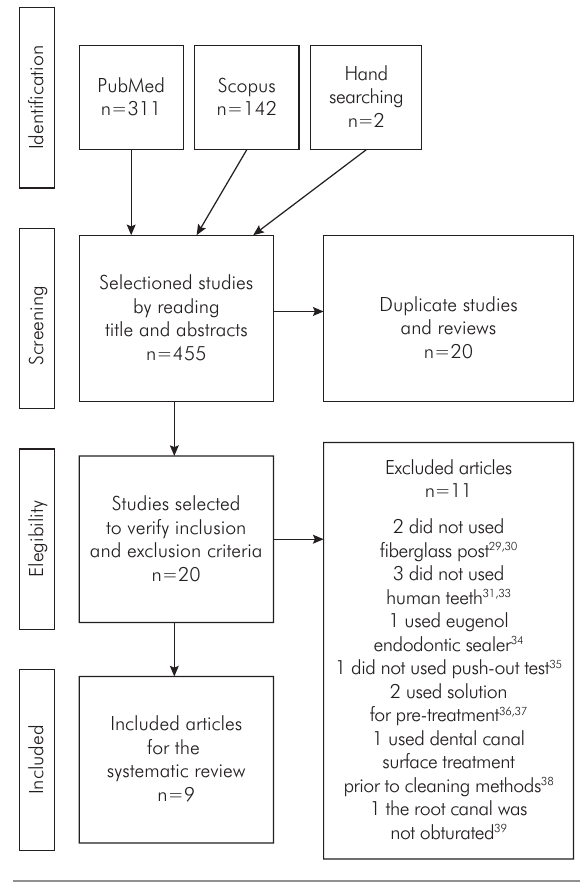
Figure 1. Flow diagram of the systematic review according to the PRISMA